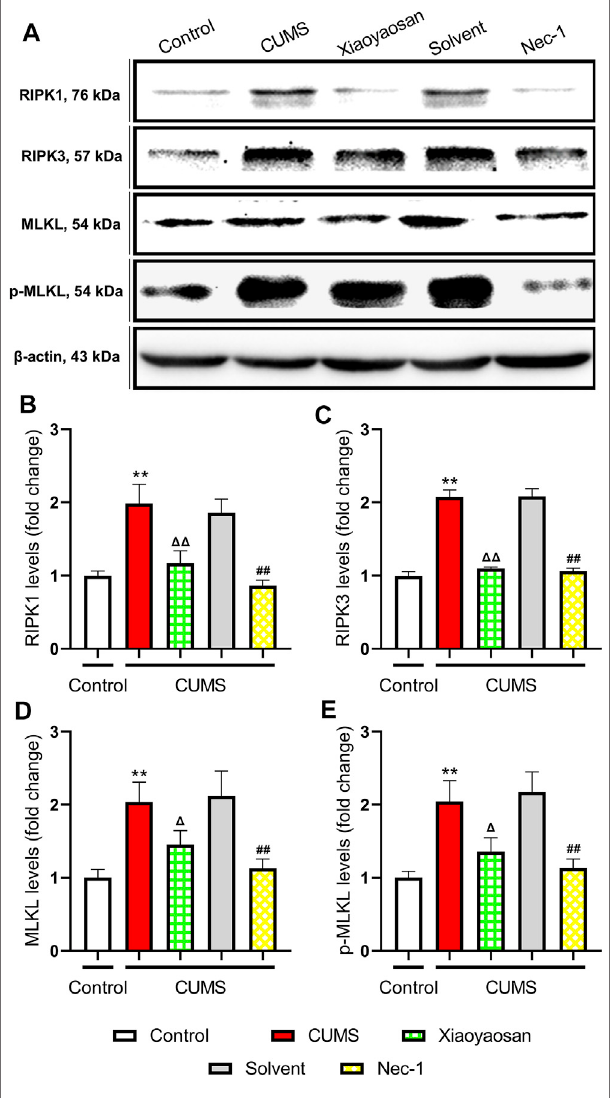
FIGURE 6 | Changes of necroptosis biomarkers in the hippocampi of CUMS mice (A) Representative micrographs of WB for necroptosis biomarkers (B) The expression of RIPK1 in the hippocampus of experimental mice (n (cid:1) 5) (C) The expression of RIPK3 in the hippocampus of experimental mice (n (cid:1) 5) (D) The expression of MLKL in the hippocampus of experimentalmice(n (cid:1) 5) (E) Theexpressionof p -MLKLinthehippocampusof experimental mice (n (cid:1) 5). Data were expressed as means ± SEM, ** p < 0.01 versuscontrolgroup; Δ p < 0.05, ΔΔ p < 0.01versusCUMSgroup;## p < 0.01 versus solvent group.